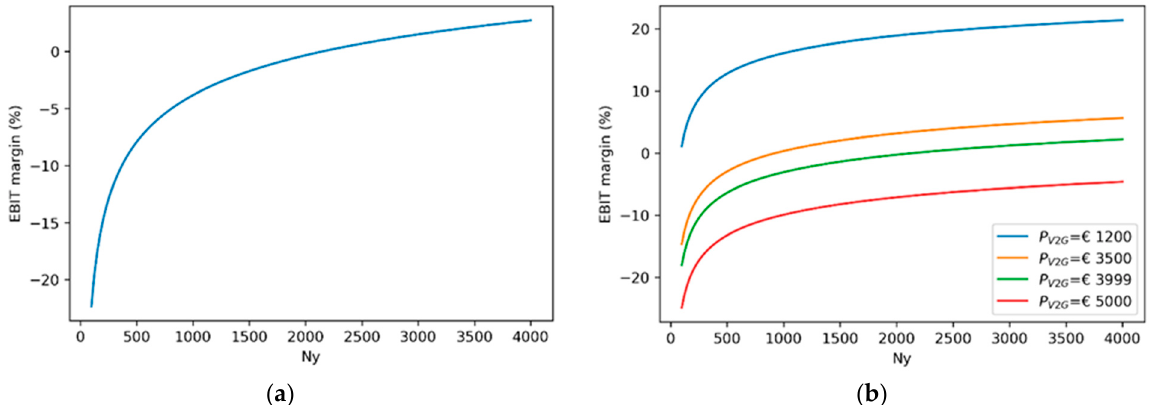
Figure 4. ( a ) EBIT margin of an entity owning a network of unidirectional EVSE in function of Ny ; ( b ) EBIT margin of an entity owning a network of V2G EVSE in function of Ny.